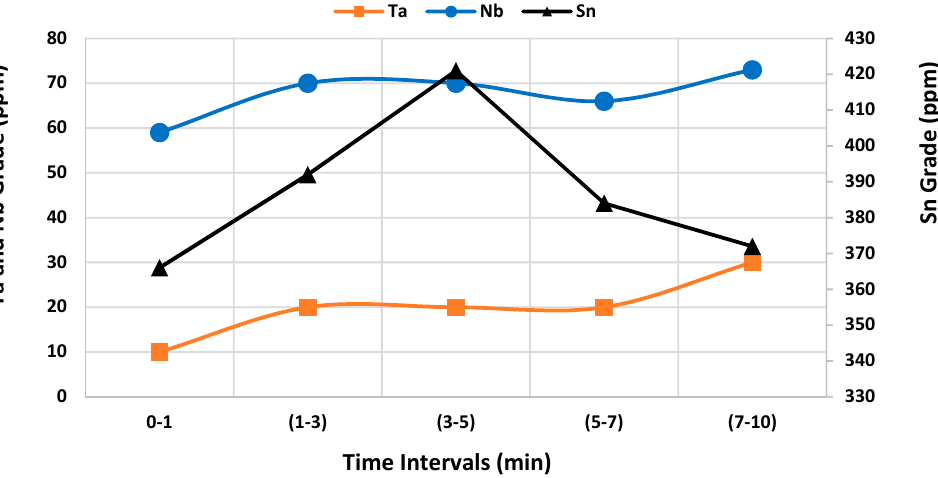
Figure 17. Grade of Ta, Nb and Sn in tailings through time.